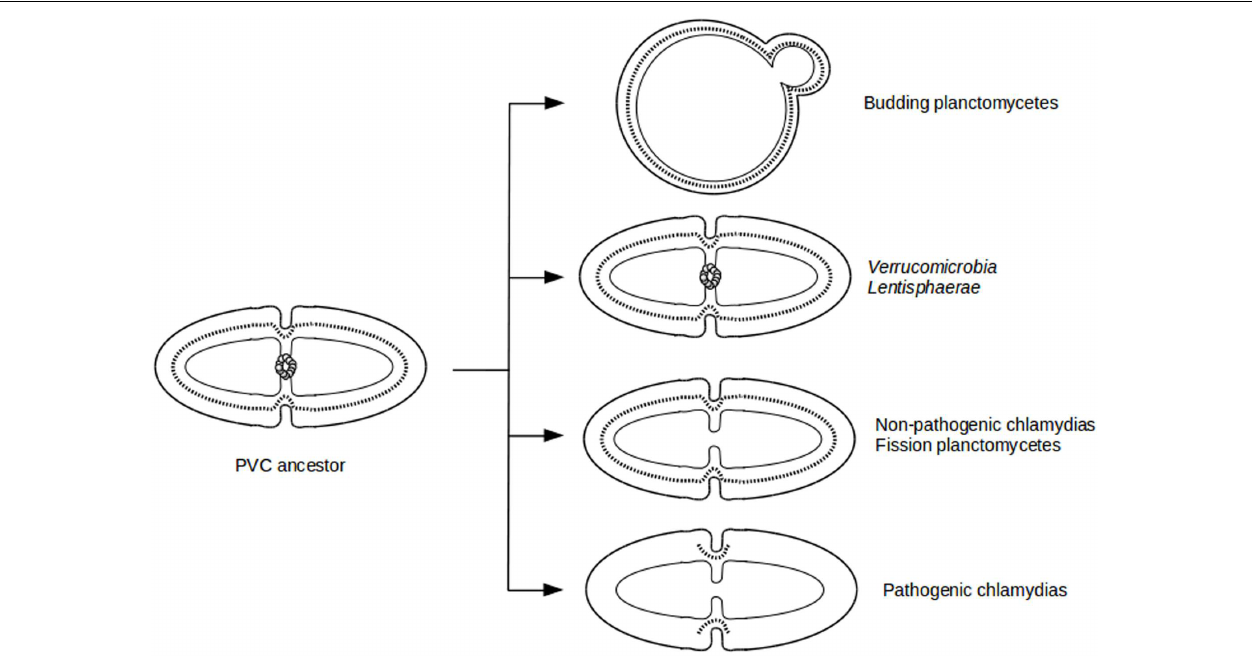
FIGURE 4 | Evolutionary cell biology of division modes in PVCs. Schematic representation of cell division modes in the last PVC common ancestor (Left) and in current PVC species (Right) . Outer and inner membranes are in thick and thin lines, respectively. PG layer is in dotted line. FtsZ proteins are represented as a ring of gray